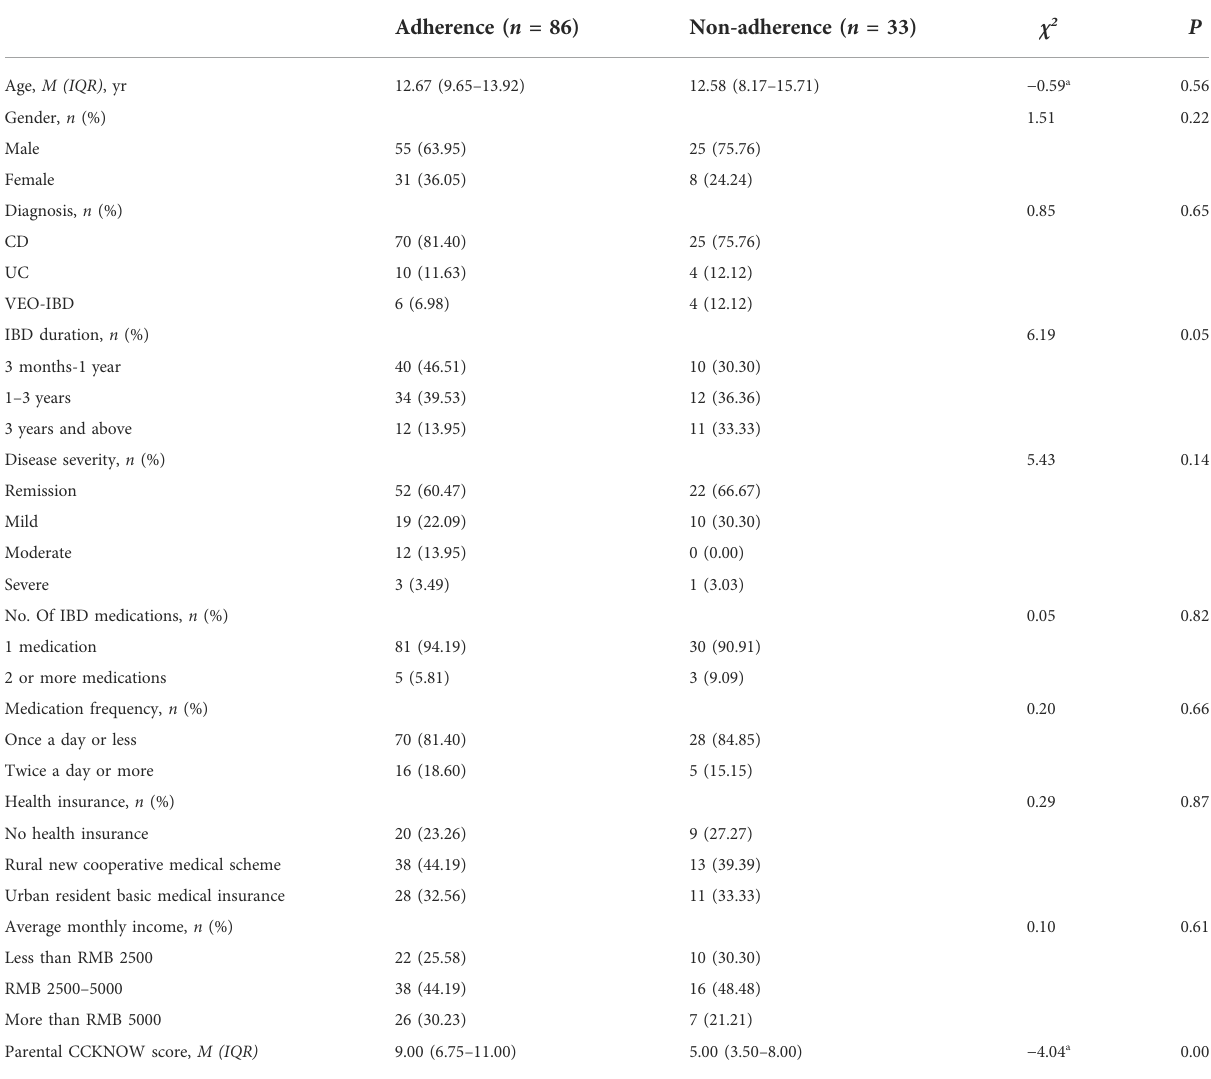
TABLE 1 Demographics and clinical characteristics of the study participants ( n = 119).